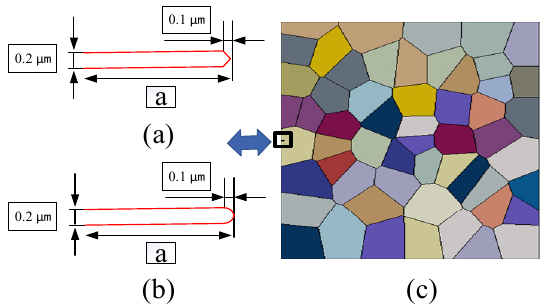
Figure 4. Schematic diagram of the crack tips: ( a ) triangular shape crack tip; ( b ) semicircular shape crack tip; ( c ) grain model of pre-crack.